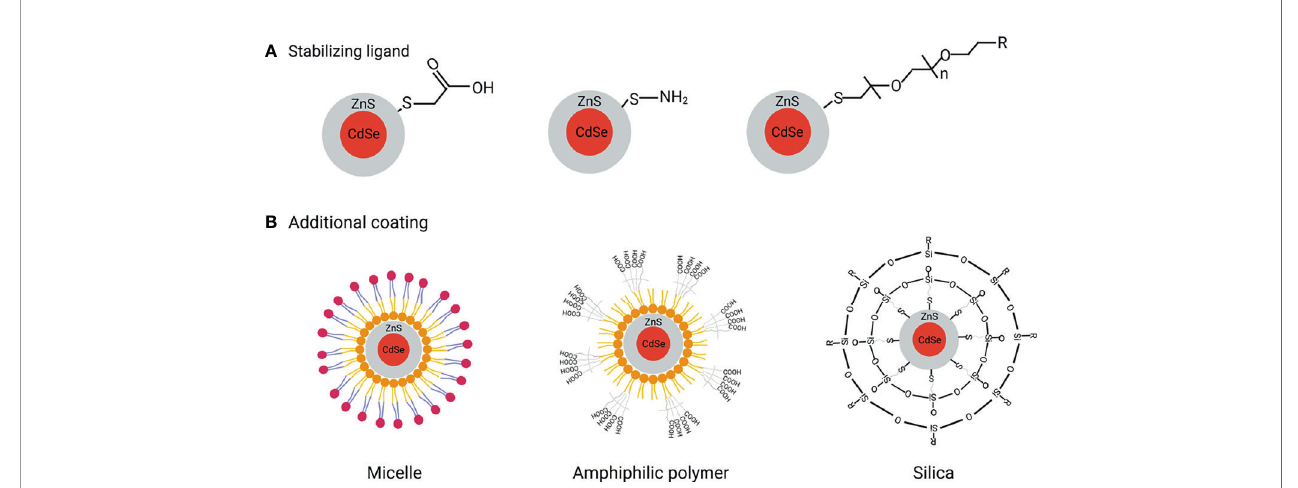
FIGURE 2 | QDs functionalization to reach excellent biological applications. (A) Ligand exchange to improve QDs stabilization, (B) Additional coating methods improve water dispersibility, biocompatibility, and